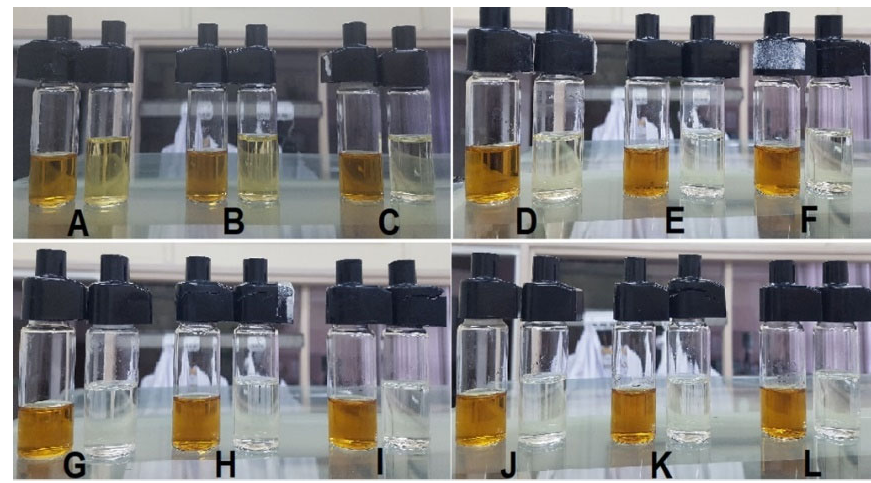
Figure 3. Cells with collected acceptor and donor fluid after copper nanoparticle diffusion process using different filters: ( A )—one filter F118; ( B )—one filter F63; ( C )—one filter F1; ( D )—two filters F118 and F63; ( E )—combination of three filters F118, F63, and F1; ( F )—two filters F1; ( G )—three filters F1; ( H )—one filter F9*; ( I )—two filters F9*; ( J )—three filters F9*; ( K )—combination of filters in the order of F1, F9*; and F1; ( L )—combination of filters F9*, F1, and F9*.